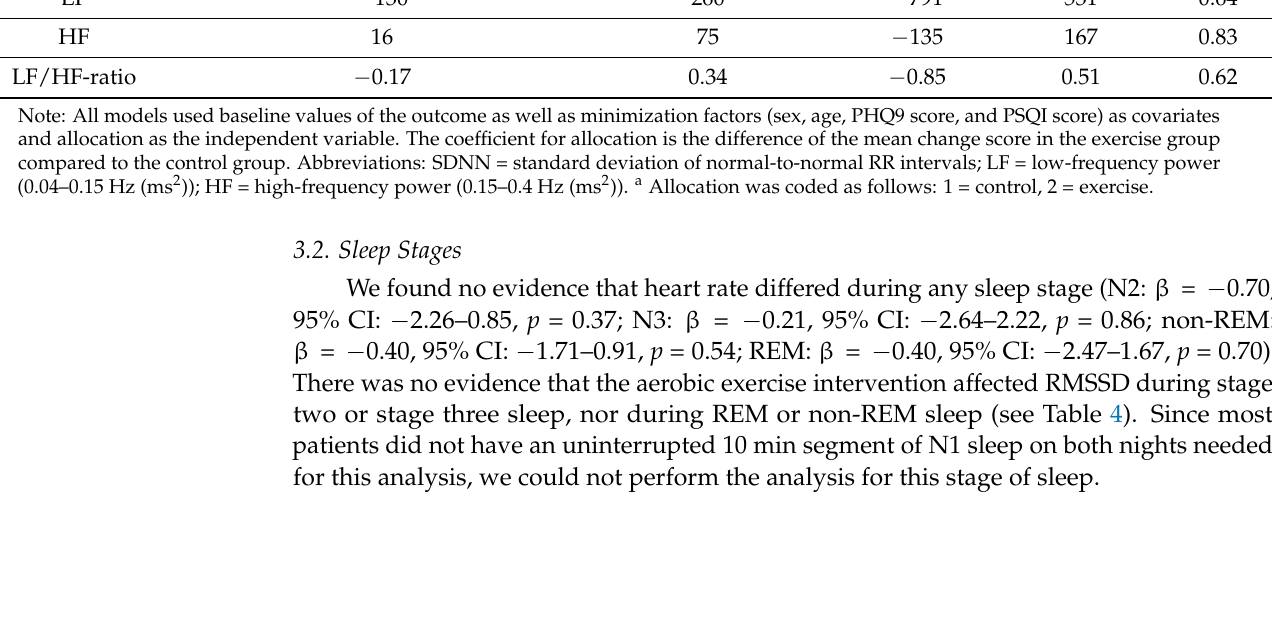
or only tricyclic antidepressants, also confirmed these results. Table 3. Coefficients of exercise allocation in intent-to-treat analysis ANCOVA models predicting HRV outcomes during sleep period. Estimate for Exercise Al- Standard Error Outcome location a ( 𝜷 )